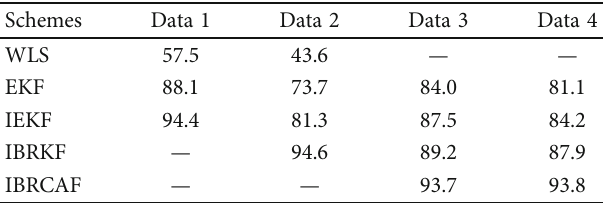
“—” means no use of the algorithm for the